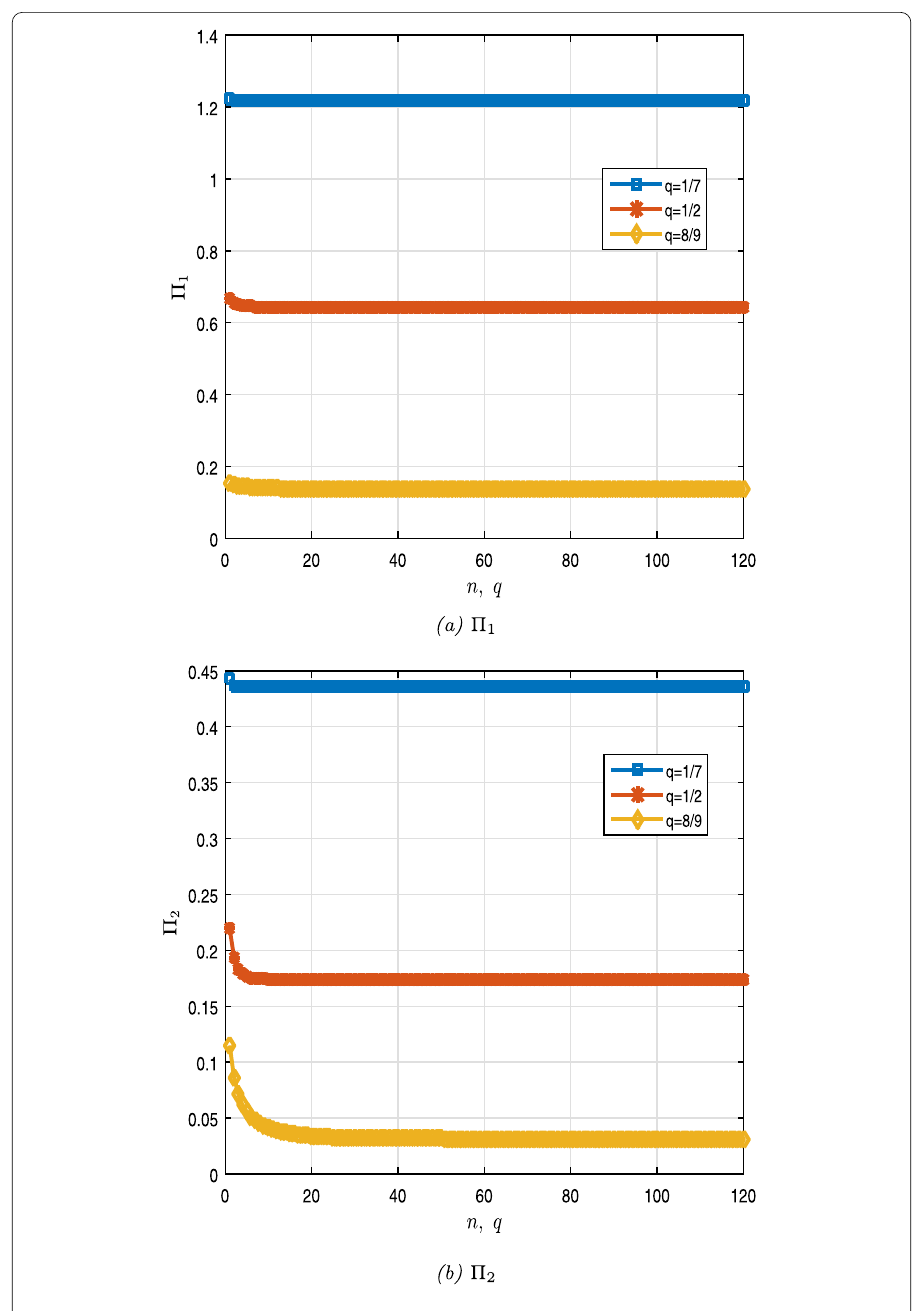
Figure 2 Graphical representation of (cid:14) i for q = 1